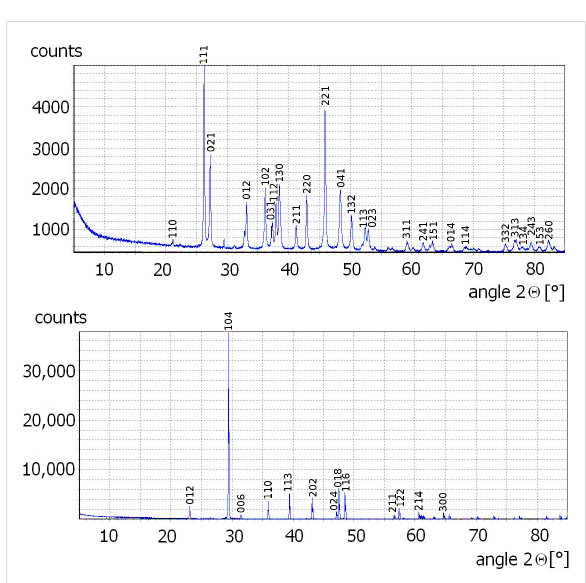
Figure 2: X-ray diffraction patterns of precipitated aragonite (upper) and calcite rhombohedrons (lower). Purity is 96–98 wt % for aragonite and 99–100 wt % for calcite as evaluated with the BRASS software suite [6]. Indexing according to data from [7] (aragonite) and [8]